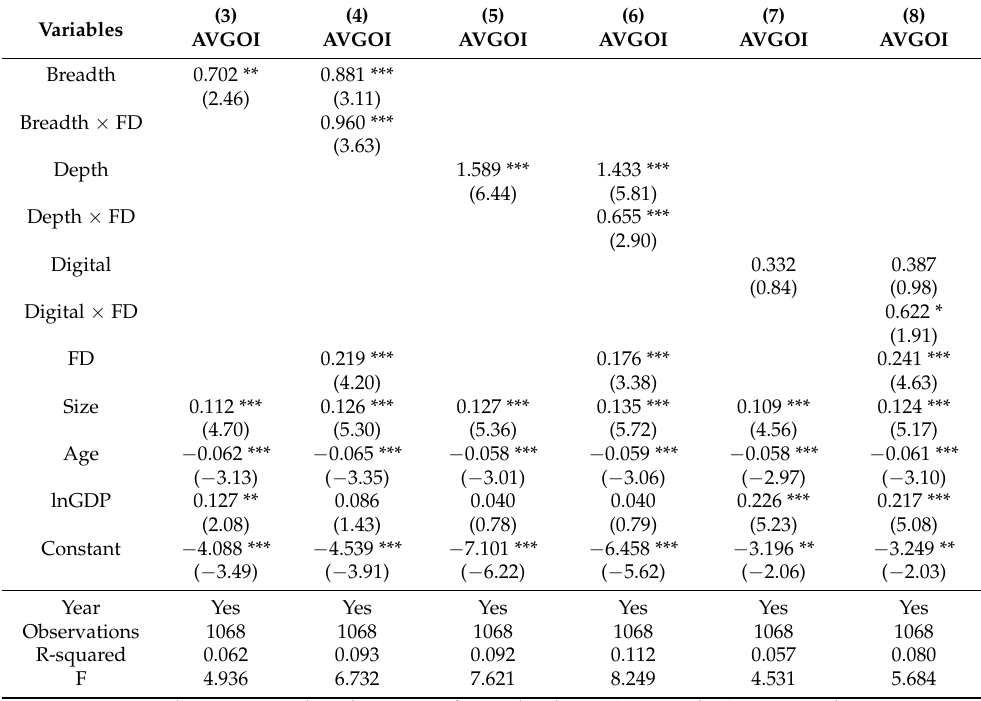
Table 8. Sub-dimensional moderating effect.